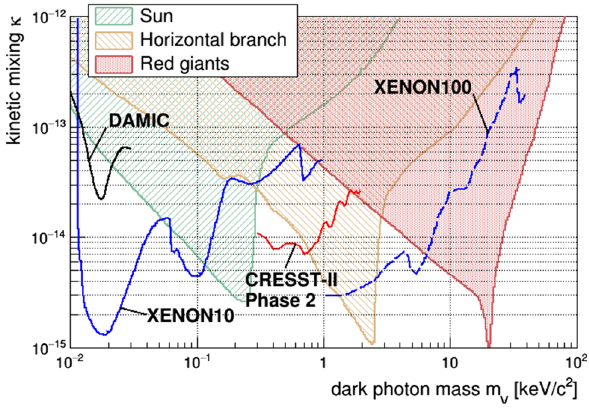
Fig. 8 Upper limits on the kinetic mixing of dark photons. Limits from anomalous energy loss in the sun, horizontal-branch stars, and red giants are shown as shaded regions [20]. Limits from XENON10 andXENON100[20]areshownas( blue ) solid and dashedlines ,respec- tively. The limit from DAMIC [21] is shown as solid black line . Our limit obtained from data from CRESST-II Phase 2 is depicted as a ( red ) solid